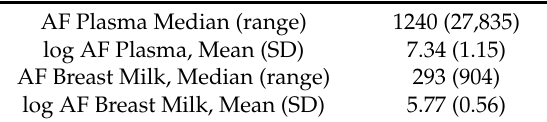
Distribution of AF (arbitrary units) in plasma and breast milk, before and after log-transformation. Figure 1. ( a ) Distribution of log AF-levels (arbitrary units) in the plasma Kolmogorov–Smirnov test of normality, p < 0.05. ( b ) Distribution of log AF-levels (arbitrary units) in breastmilk. Kolmogorov– Smirnov test of normality, p < 0.05.